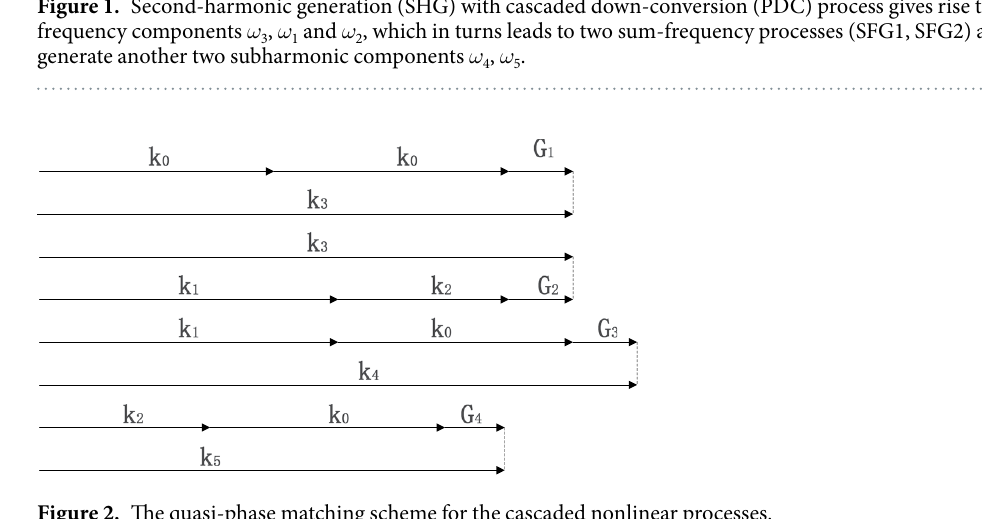
Figure 2. The quasi-phase matching scheme for the cascaded nonlinear